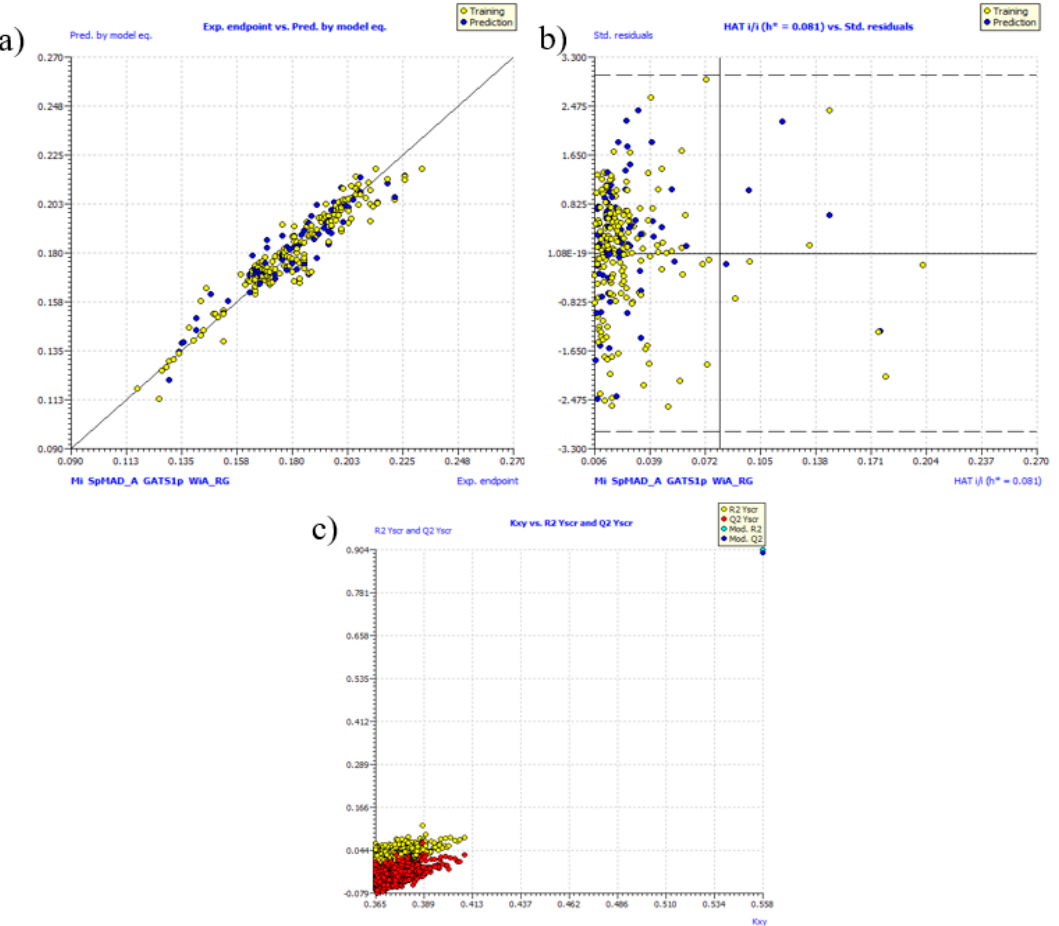
Figure 1. ( a ) Correlation plot of the experimental refractive index data vs. that predicted by the model; ( b ) Williams plot; and ( c ) the y -scrambling plot, where the red dots are for the R 2 values and the yellow dots are for Q 2 values.